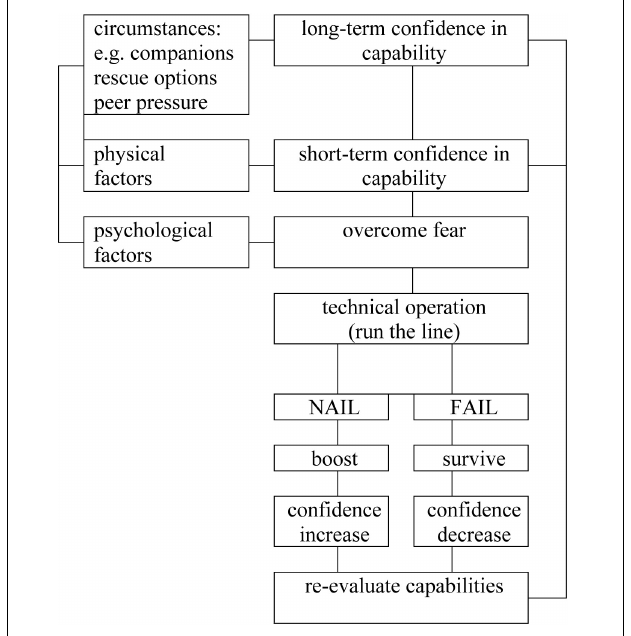
FIGURE 2 | A generalized nail-or-fail model for aging adventure